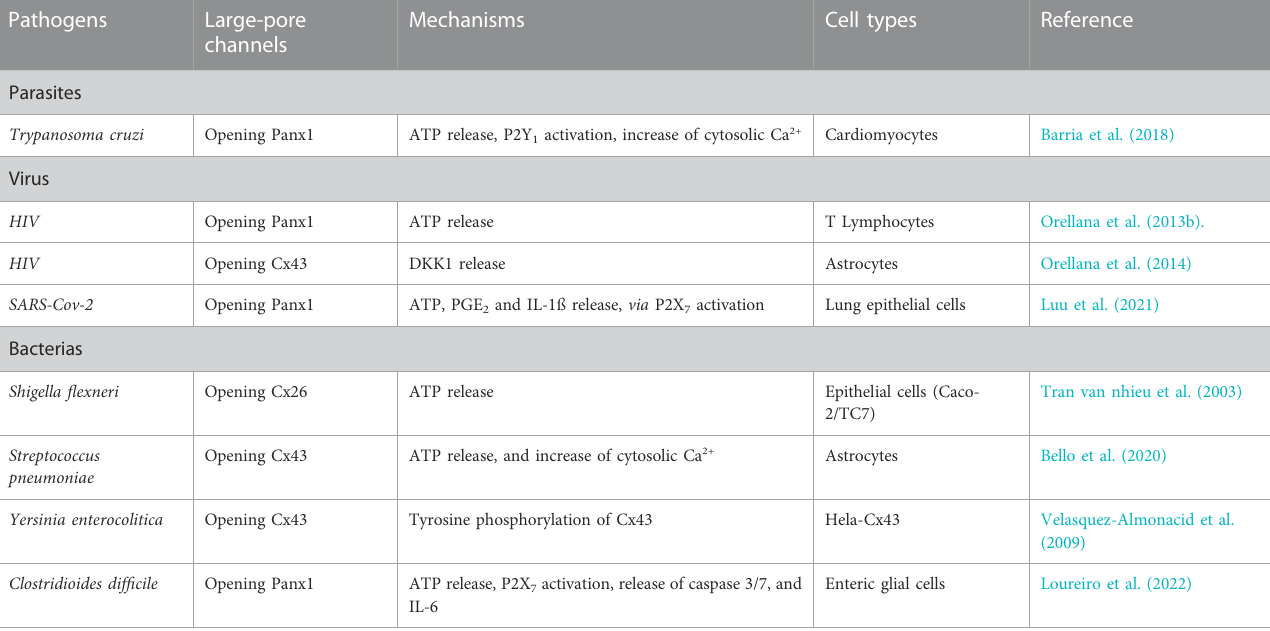
TABLE 1 Key publications describing the functional regulation of large-pore channels by pathogens.